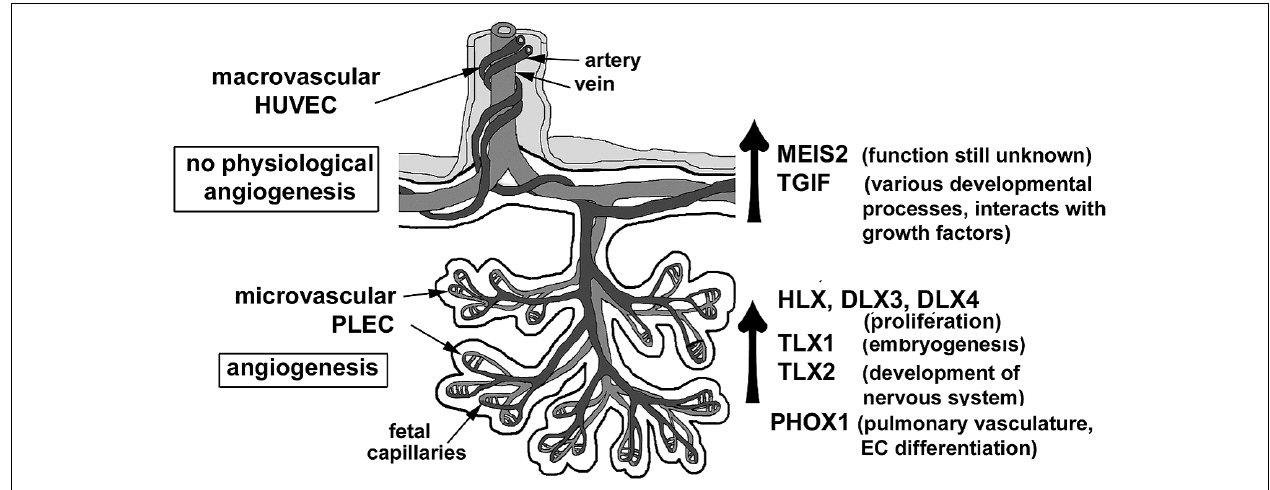
FIGURE 2 |A schematic diagram as illustrated describes the two distinct processes of vasculogenesis and angiogenesis involved in fetoplacental vascular development in human pregnancy.Adapted and modified from Murthi etal. (2008).